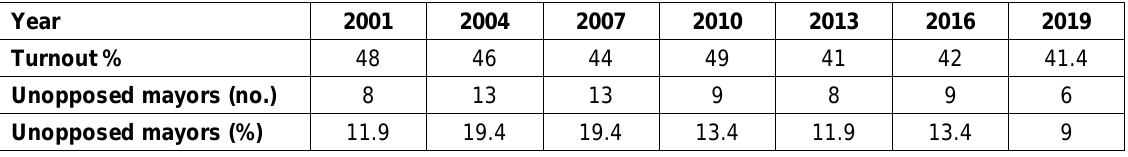
Table 2: Overall local voter participation and unopposed